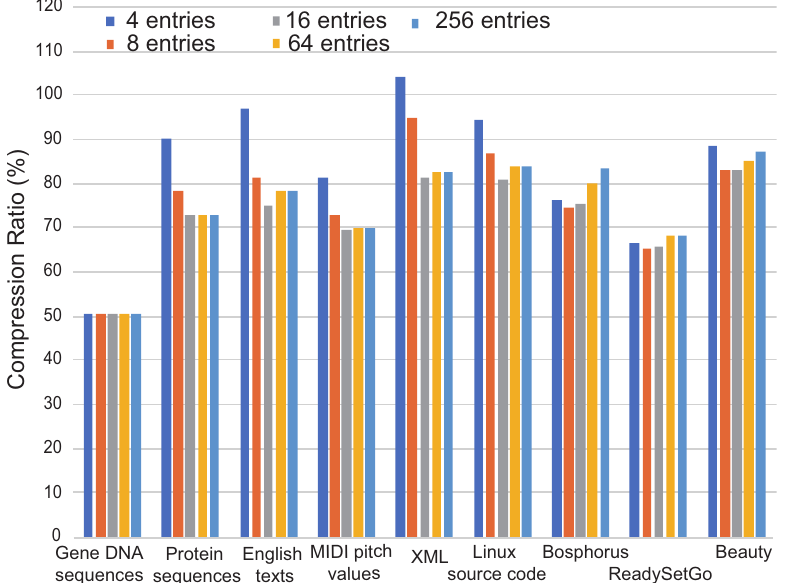
Figure 8. Comparisons of compression ratios of ASE coding with varying the number of look-up table